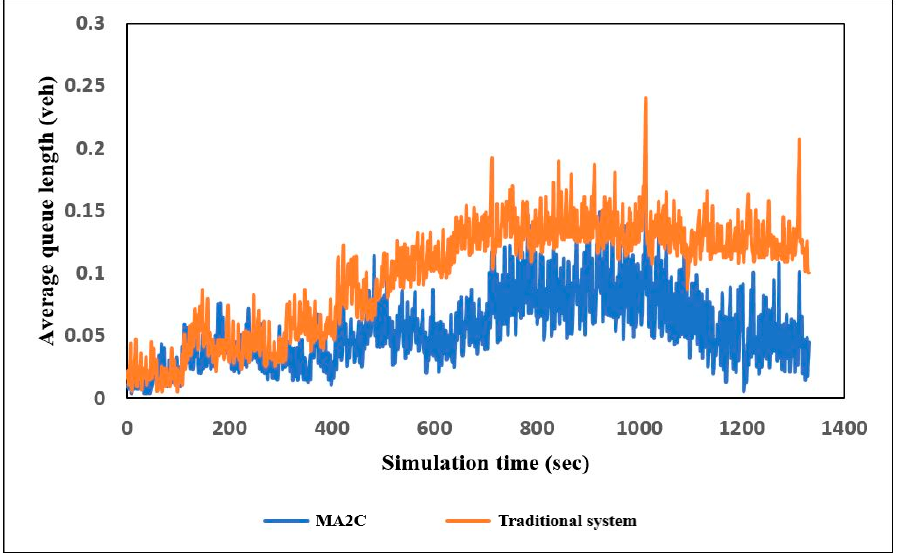
Figure 11. Average queue length in Shiraz traffic network.